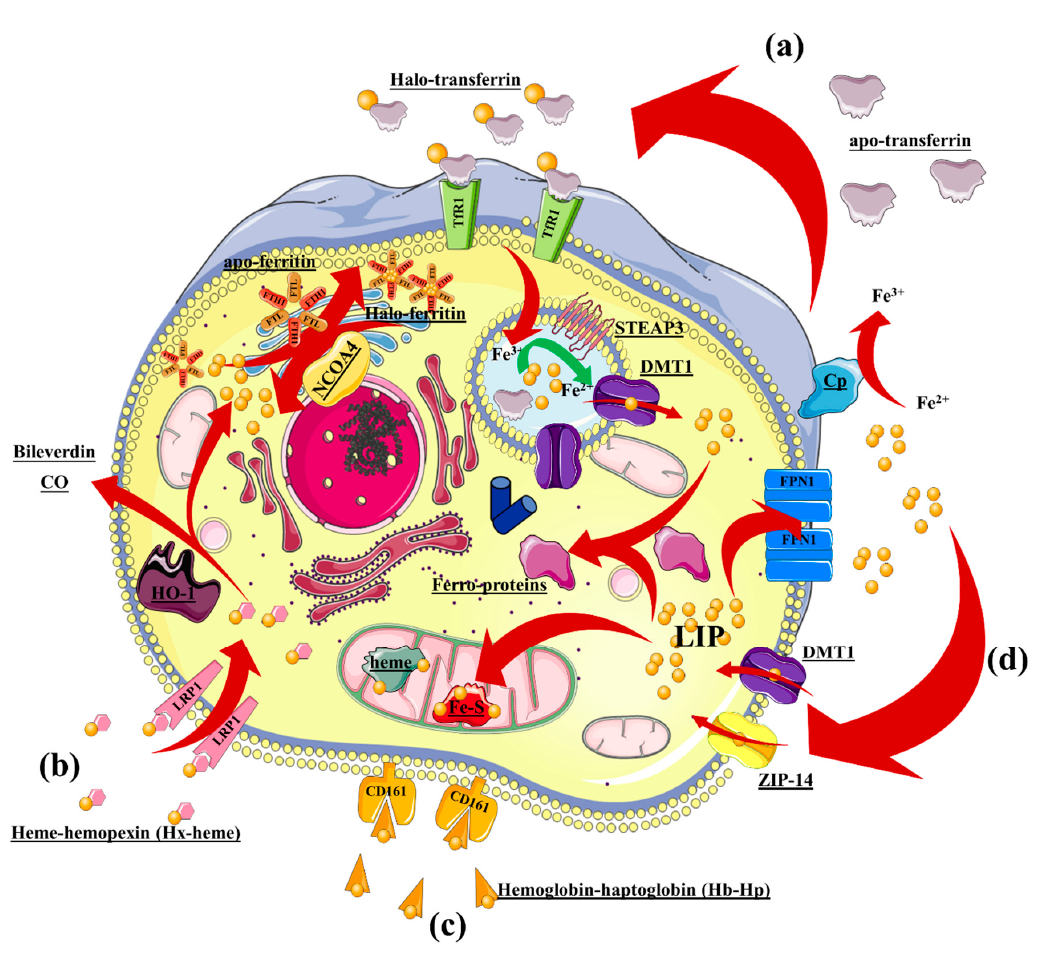
Figure 2. Overview of intracellular iron metabolism in macrophages. Iron intake is mediated by 4 major pathways: ( a ) Extracellular iron is scavenged by apo-transferrin into halo-transferrin, which is recognized be the transferrin receptor and internalized; ( b ) iron-containing heme–hemopexin is internalized after recognition by the LRP1 receptor; ( c ) iron-containing hemoglobin–haptoglobin is recognized by the CD161 receptor and internalized; and ( d ) non-Tf-bound iron ions (Fe 2+ ) can be transported from the extracellular space into the cells by the transporters DMT1 and ZIP-14. CO, carbon monoxide; DMT-1, divalent metal transporter type 1; LIP, labile iron pool; LRP1, LDR-related receptor type 1; NCOA, nuclear receptor coactivator 4; STEAP3, six-transmembrane epithelial antigen of the prostate 3; ZIP-14, zinc transporter ZRT/IRT-like protein-14. Other iron sources can also contribute to the intracellular LIP, and these comprise dying erythrocytes and other cells phagocytosed